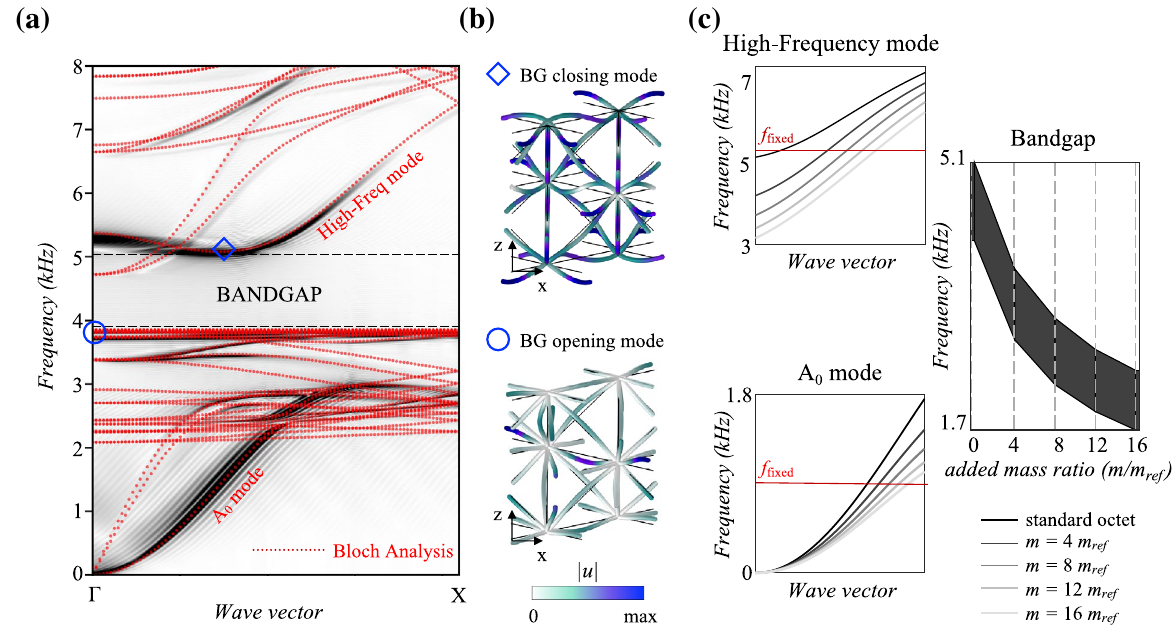
Figure 2. Dispersion analysis. ( a ) Band structures of the standard octet crystal and finite plate (Fig. 1a, b) computed with COMSOL Multiphysics (red) and Real-ESSI (black). The Ŵ - X wavevector in the reciprocal space represents waves propagating in the e x direction in the physical system. The red curves are obtained via Bloch-eigenvalue analysis on the fundamental unit cell of Figure 1a. The black branches derive from the fast Fourier transform (FFT) of the z -wise signal recorded on the receivers of Figure 1b, where they are denoted as output points and colored in blue. ( b ) Bandgap (BG) opening and closing eigenmodes, respectively at 3.85 and 5.08 kHz. ( c ) Sensitivity analysis on the dispersion curves of the customized octet cell (Fig. 1c) for increasing m , where m ref = ρ A 2 t strut